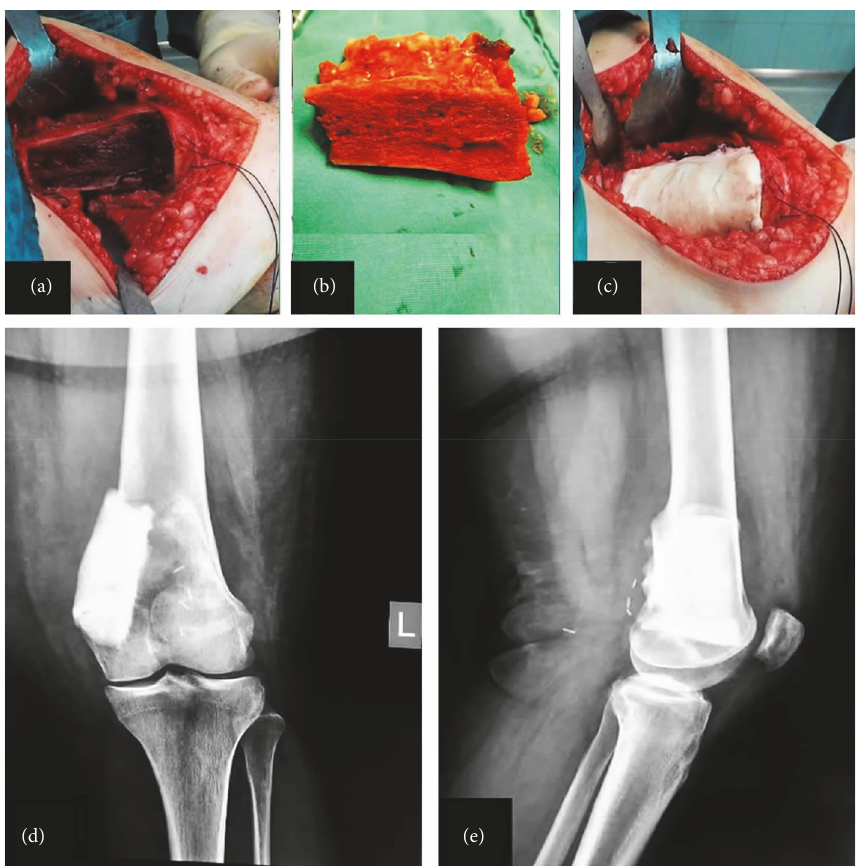
Figure 9: Intraoperative images with complete excision of the posterior-medial part of the distal femur (a), the excised specimen (b), and polymethyl-methacrylate (PMMA) used to fill the osseous void (c). Postoperative radiographs of anteroposterior (d) and lateral (e) views showing the PMMA in the posterior-medial part of the distal femur.